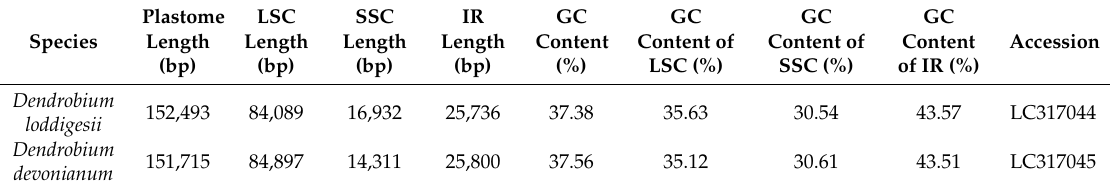
Table 1. Genome feature of the two newly sequenced Dendrobium plastomes.